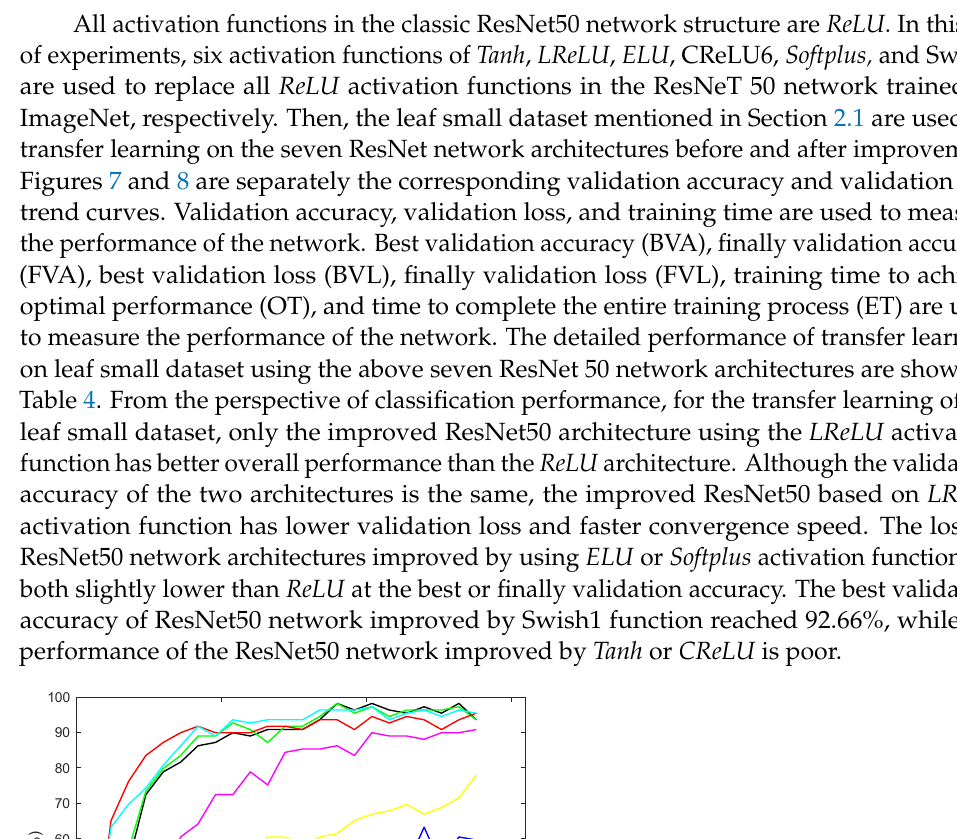
Figure 8. Trends of validation loss for transfer learning on ResNet50 with seven different activation functions. 3.2. Improving ResNet50 with Mixed Activation Function According to the training results in Section 3.1, considering the verification accuracy and verification loss, we selected five activation functions ( ReLU , LReLU , ELU , Softplus, and Swish ) with good performance to improve the ResNet50 network architectures, and explore the impact of mixed use of activation functions on the performance of deep network. Considering the structural characteristics of the residual block, two of the above five activation functions are selected each time to improve the ResNet50 network architecture. Figure 9 is a schematic diagram of the residual block structure of mixing two activation functions, in which activation 1 represents the activation function used after addition (in particular, the first activation function of the input layer of the ResNet50 network is also divided into activation 1), and activation 2 represents another activation function used in other positions. The five selected activation functions are used as activation 1, respectively, and there are 20 combinations in total. The results of the transfer learning for the leaf small dataset of the ResNet50 network structure changed by these 20 mixed activation functions are shown in Table 5. Figure 10 shows the validation accuracy and validation loss curves of these 20 improved ResNet50 network architectures, respectively. From the experimental results, it can be seen that the performance of the ResNet50 network changed by some mixed activation functions has been improved to a certain extent, and all the mixed models have not experienced a significant drop in training